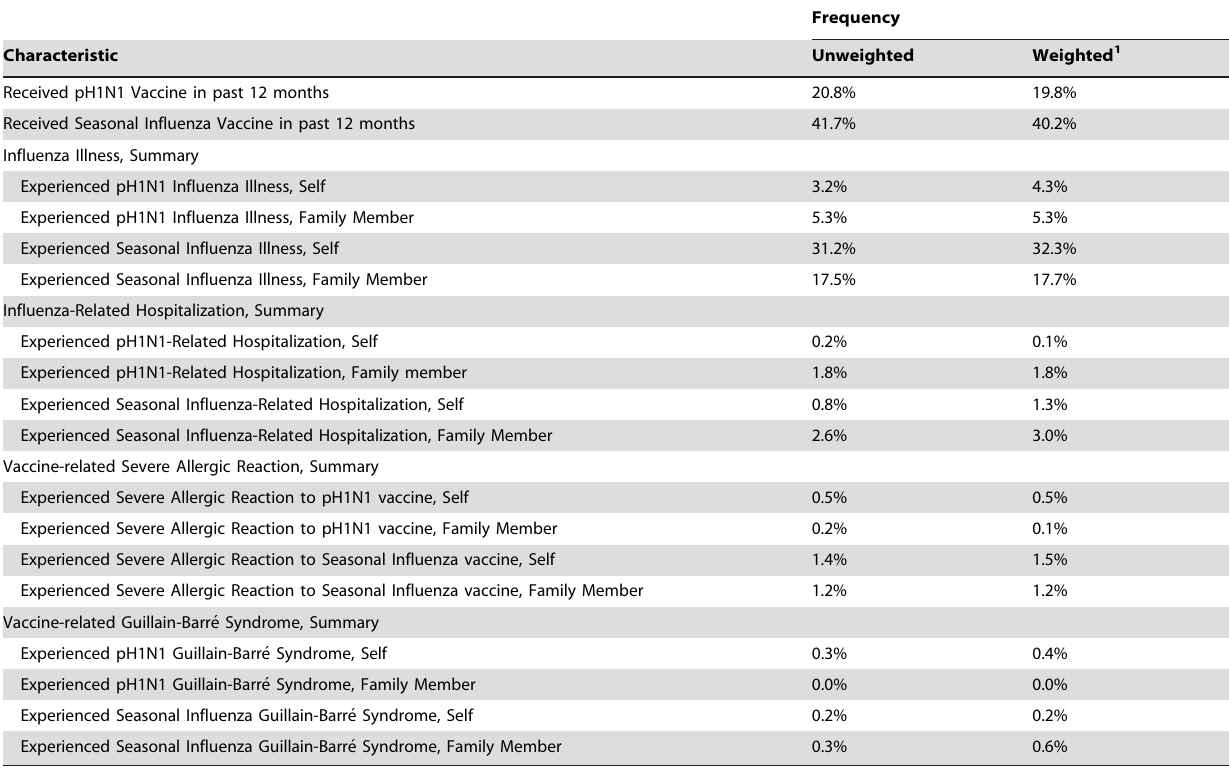
Table 2. Respondent influenza-related characteristics (n=